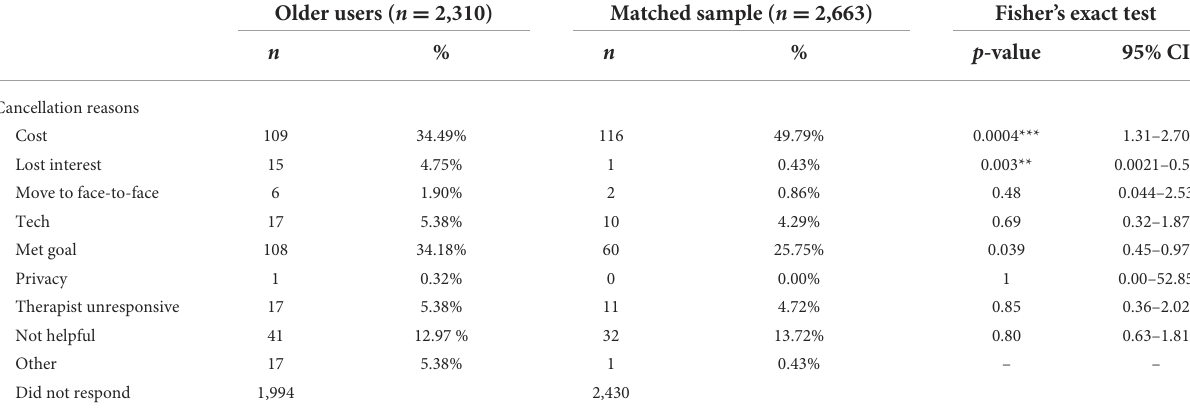
TABLE 4 Primary reason for therapy discontinuation.